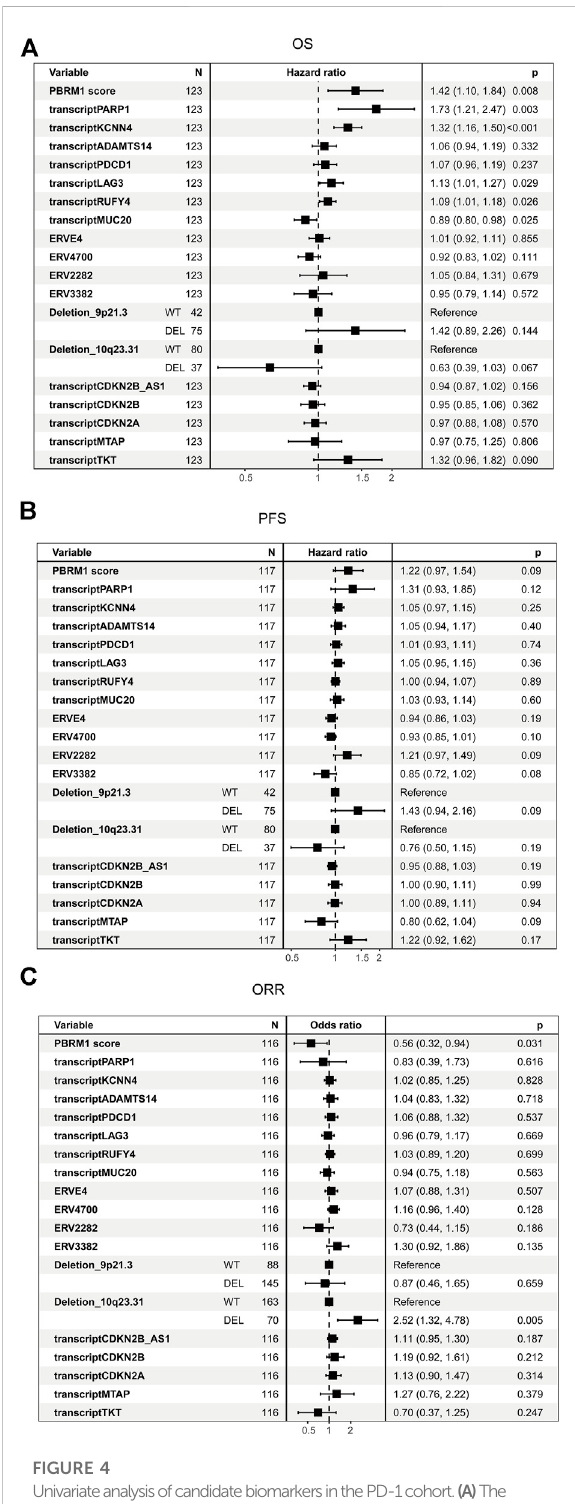
FIGURE 4 UnivariateanalysisofcandidatebiomarkersinthePD-1cohort. (A) The univariate analysis based on Cox regression was used to assess the correlation between OS and candidate biomarkers in the PD-1 cohort. (B) The univariate analysis based on Cox regression was used to assess thecorrelationbetweenPFSandcandidatebiomarkersinthePD-1cohort. (C) The univariate analysis based on logistic regression was used to assess